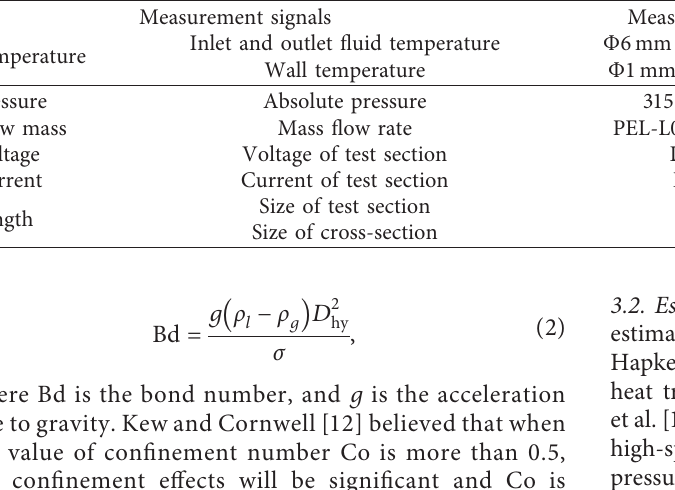
Table 3: Measurement